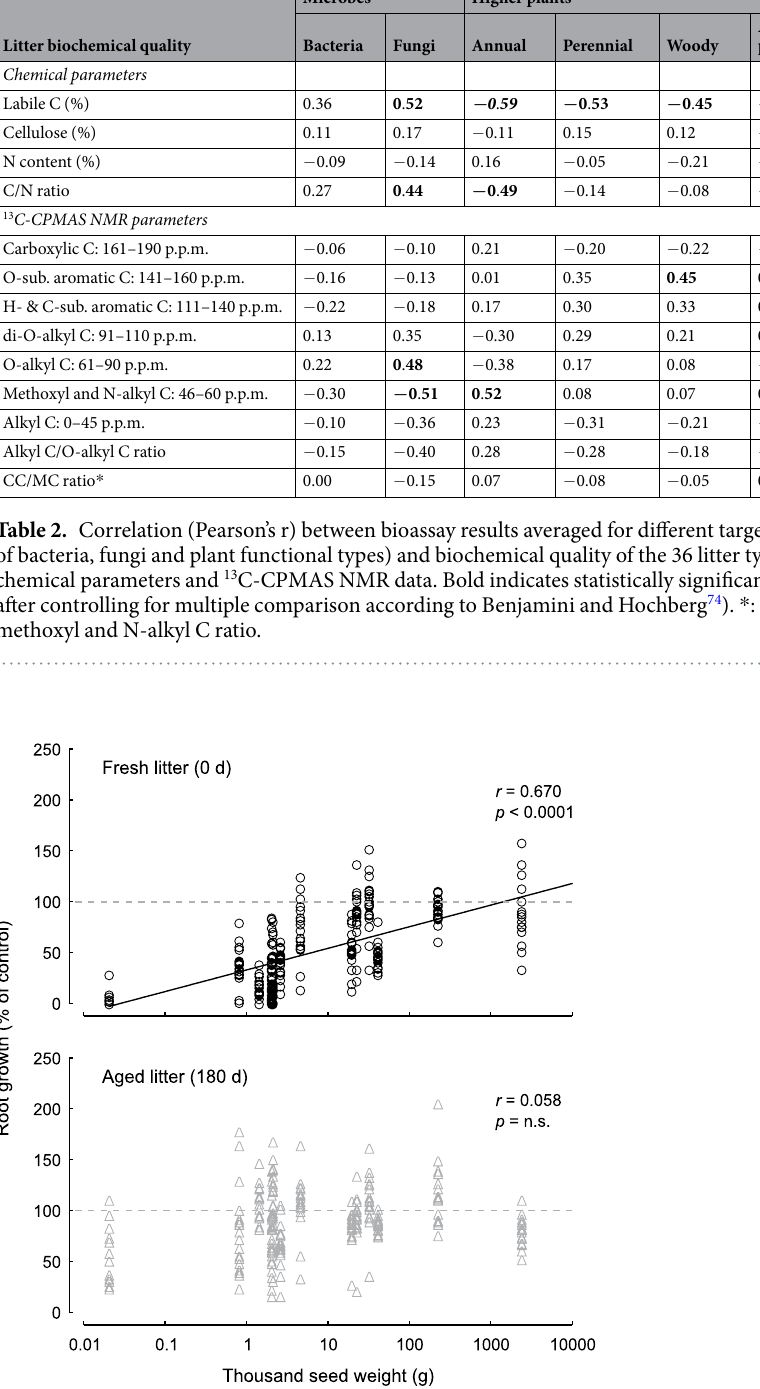
Figure 3. Relationships between seed weight and root growth of 14 target plants sown over 36 litter materials, either undecomposed (top) or decomposed for 180 days (bottom). Note logarithmic scale for seed weight. Data refer to mean growth of 10 replicates for each combination of target plant, litter species and age, as compared to the control (gray horizontal dashed line). Logarithmic fit is also reported in each panel, and symbolized with either continuous or dotted black line according to significant or not significant result, respectively.